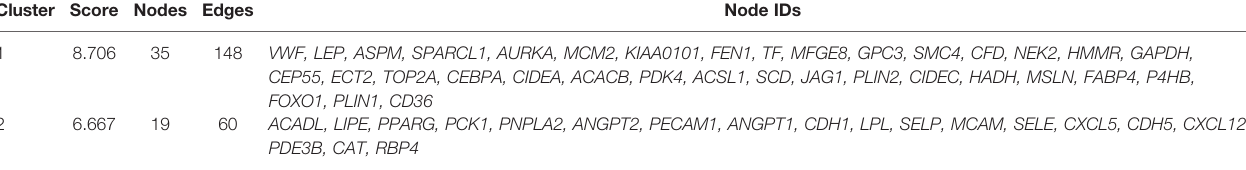
TABLE 3 | The Top 2 signi fi cantly modules. Cluster Score Nodes Edges